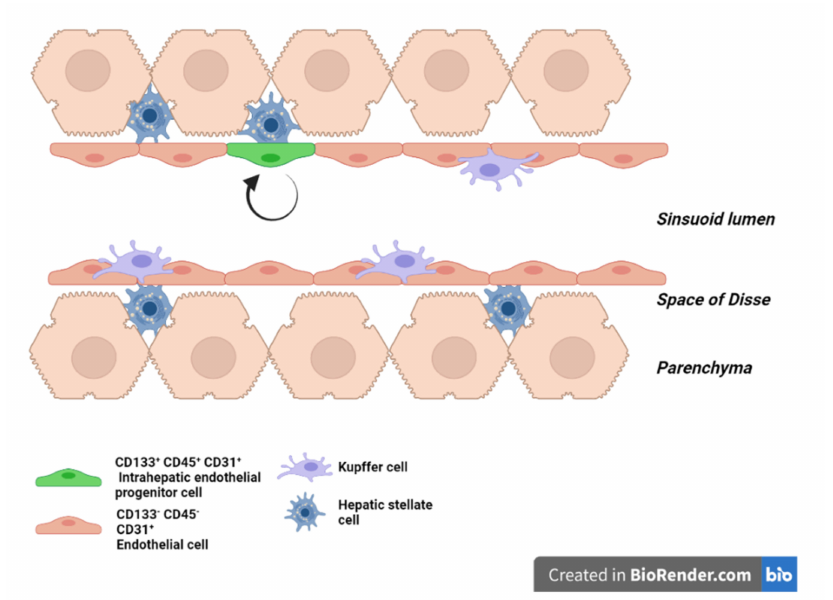
Figure 1. Liver sinusoid in homeostasis. Scheme of a liver sinusoid during homeostasis. LSEC are embraced by hepatic stellate cells in the space of Disse and in physical contact with Kupffer cells on the vascular side. Intrahepatic endothelial progenitor cells (green) ensure the renewal of the LSEC pool during